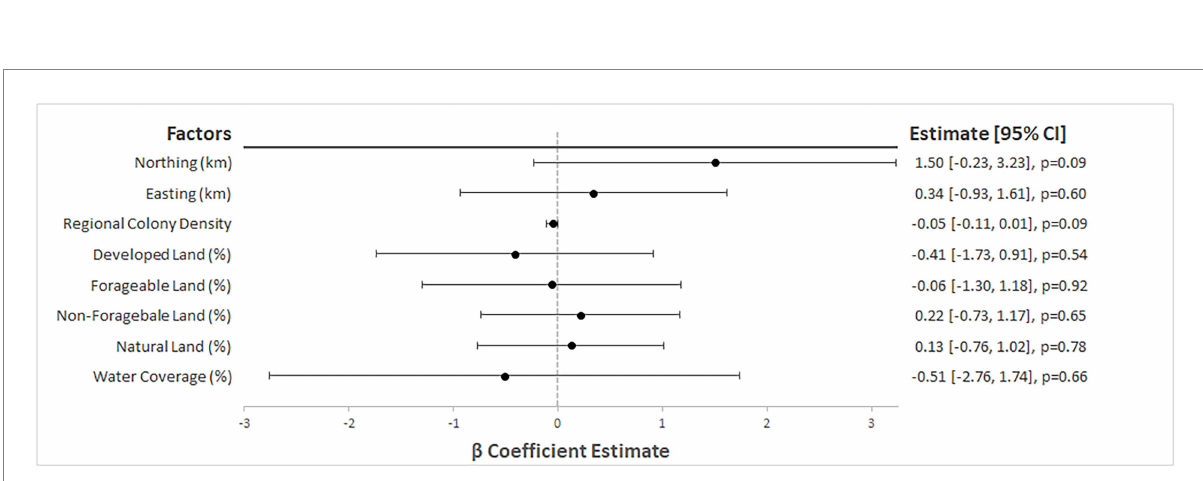
FIGURE 4 Forest plot of estimated beta coefficients from preliminary simple linear modelling of V. destructor rate in Southern Ontario managed honey bee colonies